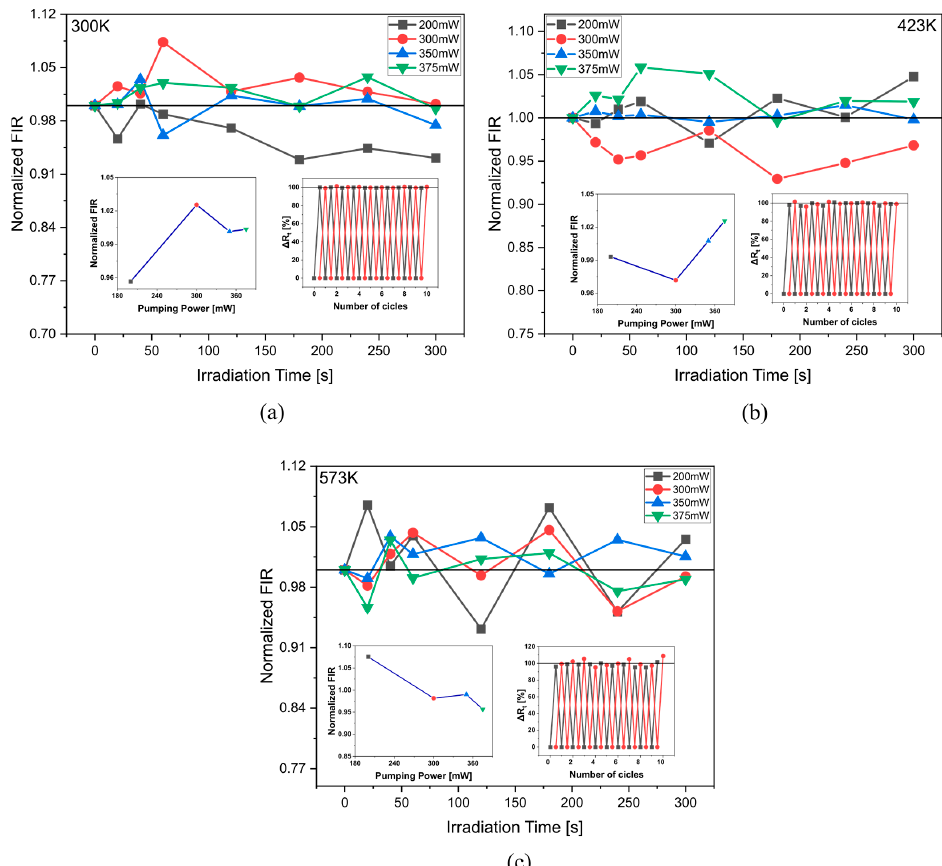
Figure 7. Normalized up ‐ conversion FIR of glass fiber (TCL ‐ TCL) versus irradiation time at ( a ) 300 K; ( b ) 423 K; ( c ) 573 K. The insets on the left show normalized UC FIR (TCL ‐ TCL) versus pumping power at 20 s irradiation time. The insets on the right show luminescent switching contrast of 980 nm excitation at 300 mW (black) and 375 mW (red).